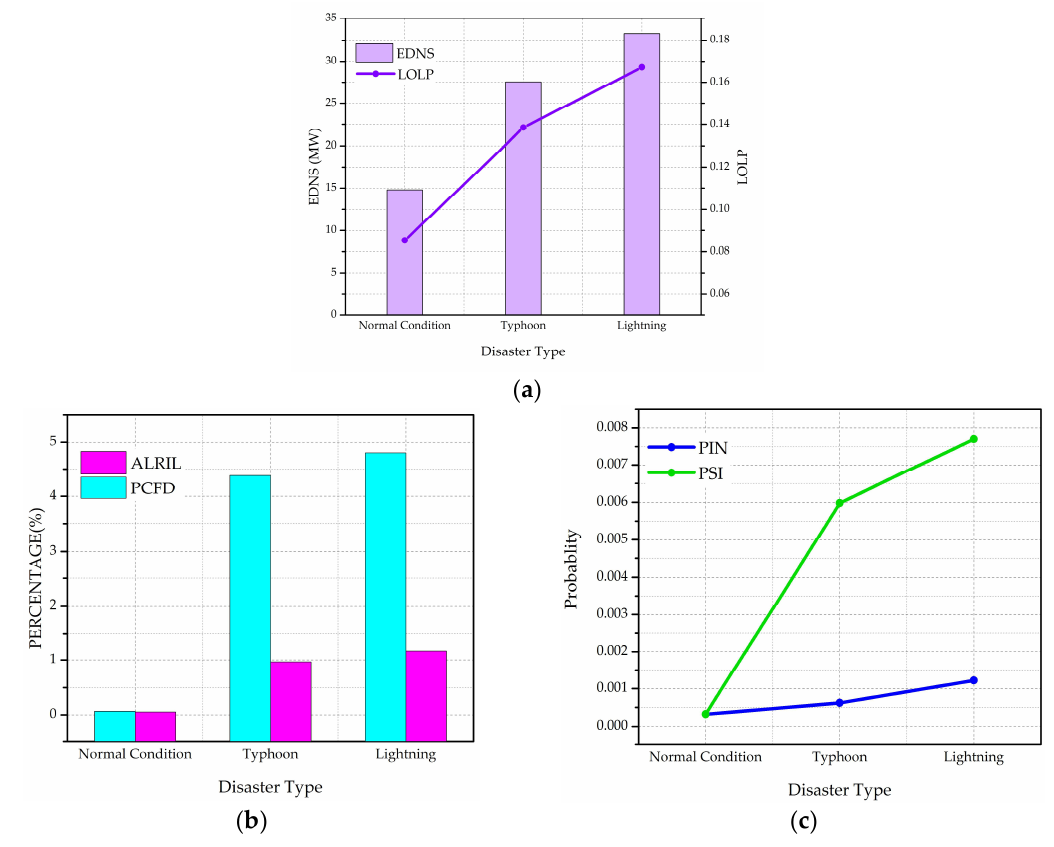
Figure 4. Partial toughness assessment metrics results: ( a ) The results of EDNS and LOLP under different types of disasters; ( b ) The results of ALRIL and PCFD under different types of disasters; ( c ) The results of PIN and PSI under different types of disasters.